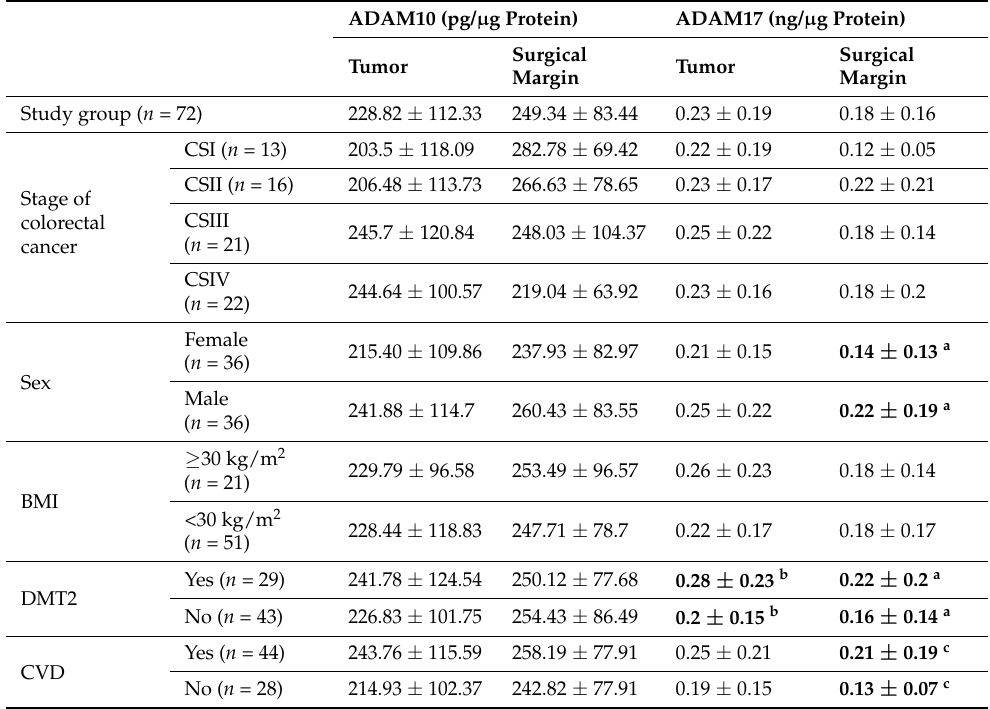
ADAM10 (pg/ µ g Protein) ADAM17 (ng/ µ g Protein) Surgical Surgical Tumor Tumor Margin Margin